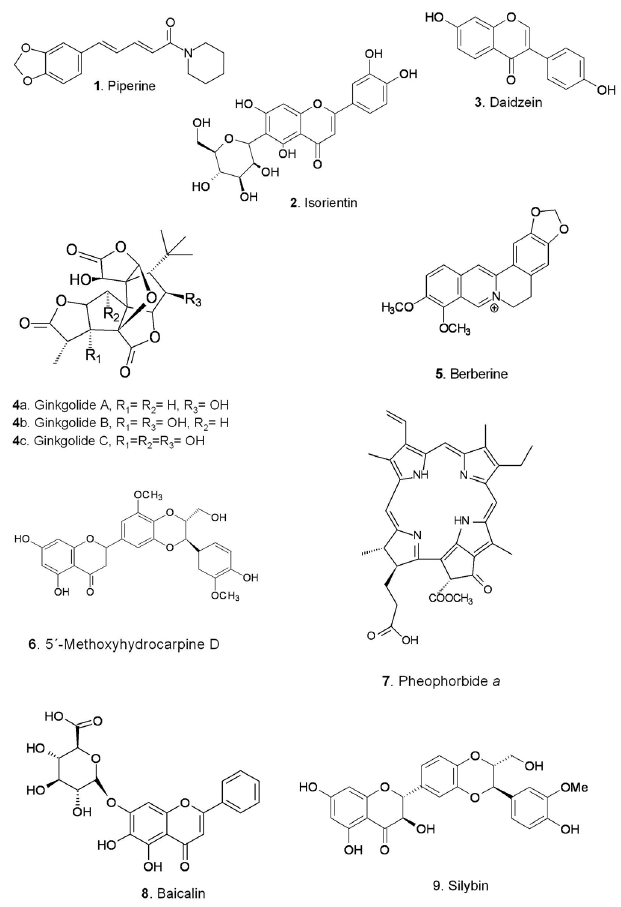
FIGURE 3 - Some natural bioactive compounds cited in the